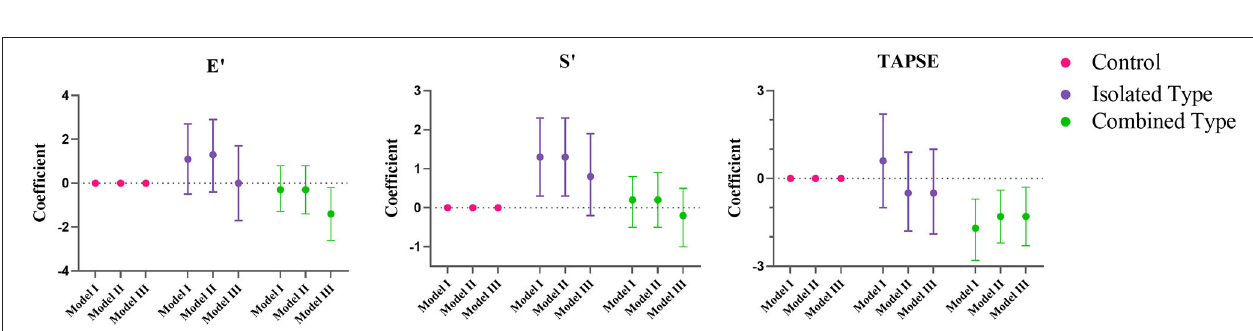
FIGURE 3 | Multiple regression analysis of right ventricular echocardiographic variables between control, isolated MMA and combined MMA patients. Multiple regression analysis was used with control group as reference. Model I was not adjusted, model II was adjusted for age, gender and BMI Z score, and model III was adjusted for age, gender, BMI Z score, blood pressure and heart rate. E’, peak early diastolic velocity; S’, peak early systolic velocity; TAPSE, tricuspid annular plane systolic